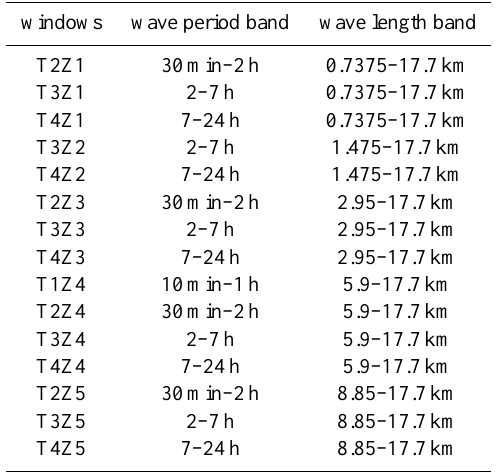
Table 4. Wave periods bands and wave length bands corresponding to the frequency- and wave number-windows used to sample the wave packets for phase and group velocity tracing